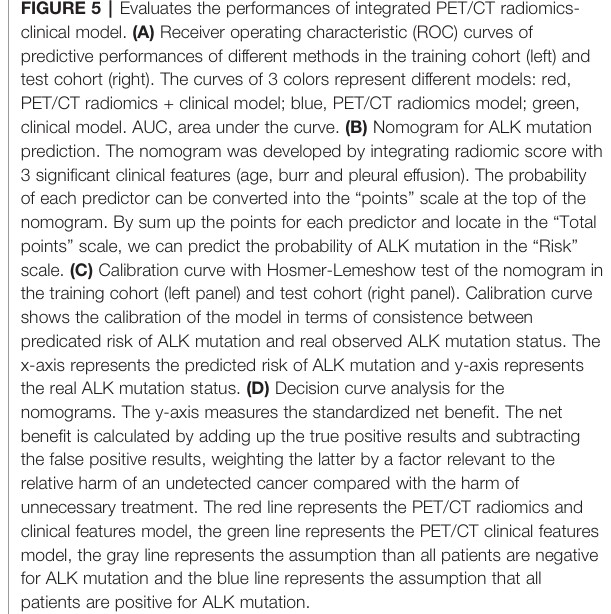
FIGURE 5 | Evaluates the performances of integrated PET/CT radiomics- clinical model. (A) Receiver operating characteristic (ROC) curves of predictive performances of different methods in the training cohort (left) and test cohort (right). The curves of 3 colors represent different models: red, PET/CT radiomics + clinical model; blue, PET/CT radiomics model; green, clinical model. AUC, area under the curve. (B) Nomogram for ALK mutation prediction. The nomogram was developed by integrating radiomic score with 3 signi fi cant clinical features (age, burr and pleural effusion). The probability of each predictor can be converted into the “ points ” scale at the top of the nomogram. By sum up the points for each predictor and locate in the “ Total points ” scale, we can predict the probability of ALK mutation in the “ Risk ” scale. (C) Calibration curve with Hosmer-Lemeshow test of the nomogram in the training cohort (left panel) and test cohort (right panel). Calibration curve shows the calibration of the model in terms of consistence between predicated risk of ALK mutation and real observed ALK mutation status. The x-axis represents the predicted risk of ALK mutation and y-axis represents the real ALK mutation status. (D) Decision curve analysis for the nomograms. The y-axis measures the standardized net bene fi t. The net bene fi t is calculated by adding up the true positive results and subtracting the false positive results, weighting the latter by a factor relevant to the relative harm of an undetected cancer compared with the harm of unnecessary treatment. The red line represents the PET/CT radiomics and clinical features model, the green line represents the PET/CT clinical features model, the gray line represents the assumption than all patients are negative for ALK mutation and the blue line represents the assumption that all patients are positive for ALK